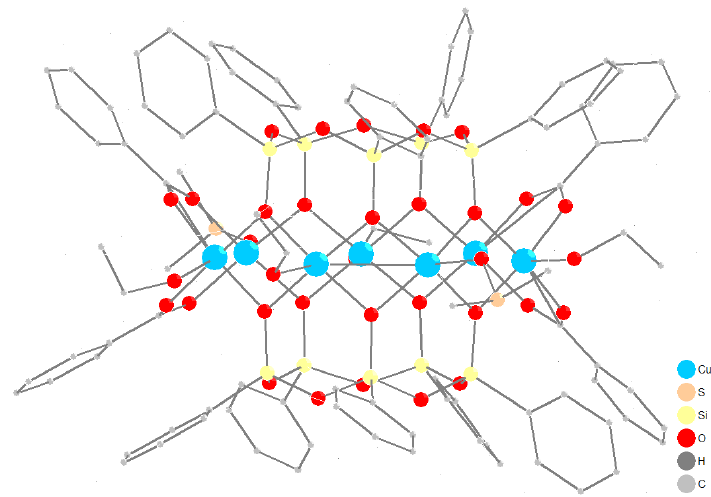
Figure 3. Side view of the molecular structure of 2 .